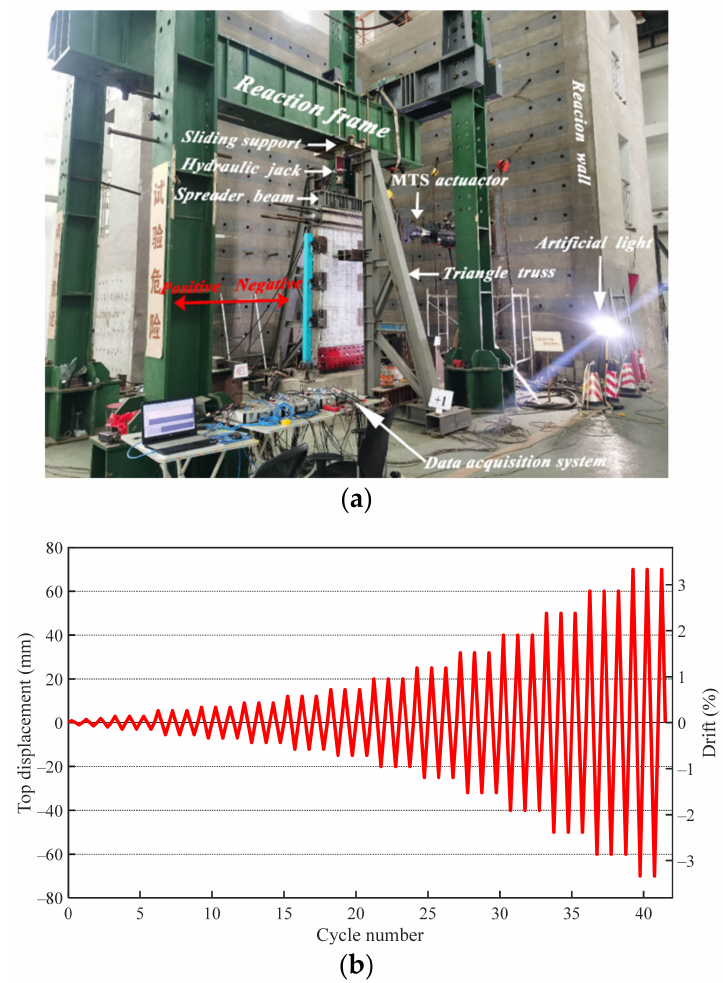
Figure 9. Testing setup and loading protocol. ( a ) Photo of W2-R; ( b ) Loading